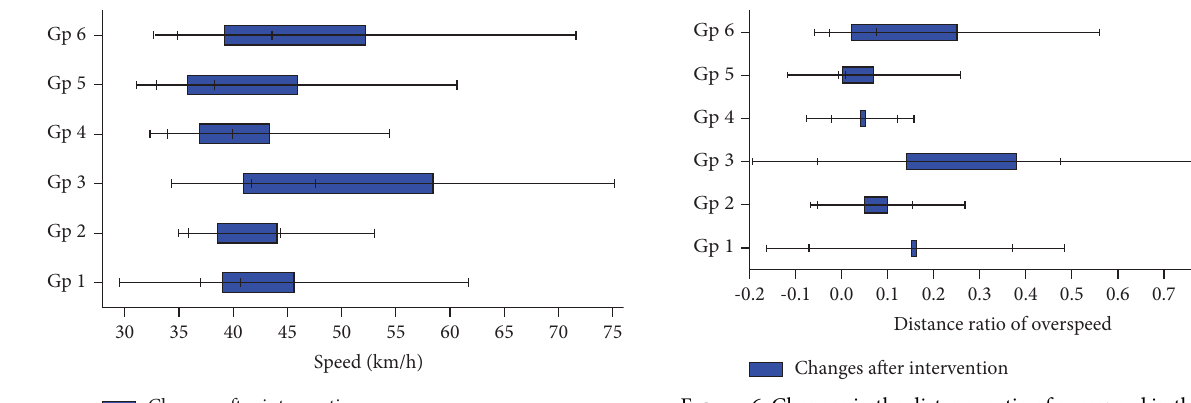
Figure 6: Changes in the distance ratio of overspeed in the 80 km/h zone after the intervention (the error bars represent the standard variance).